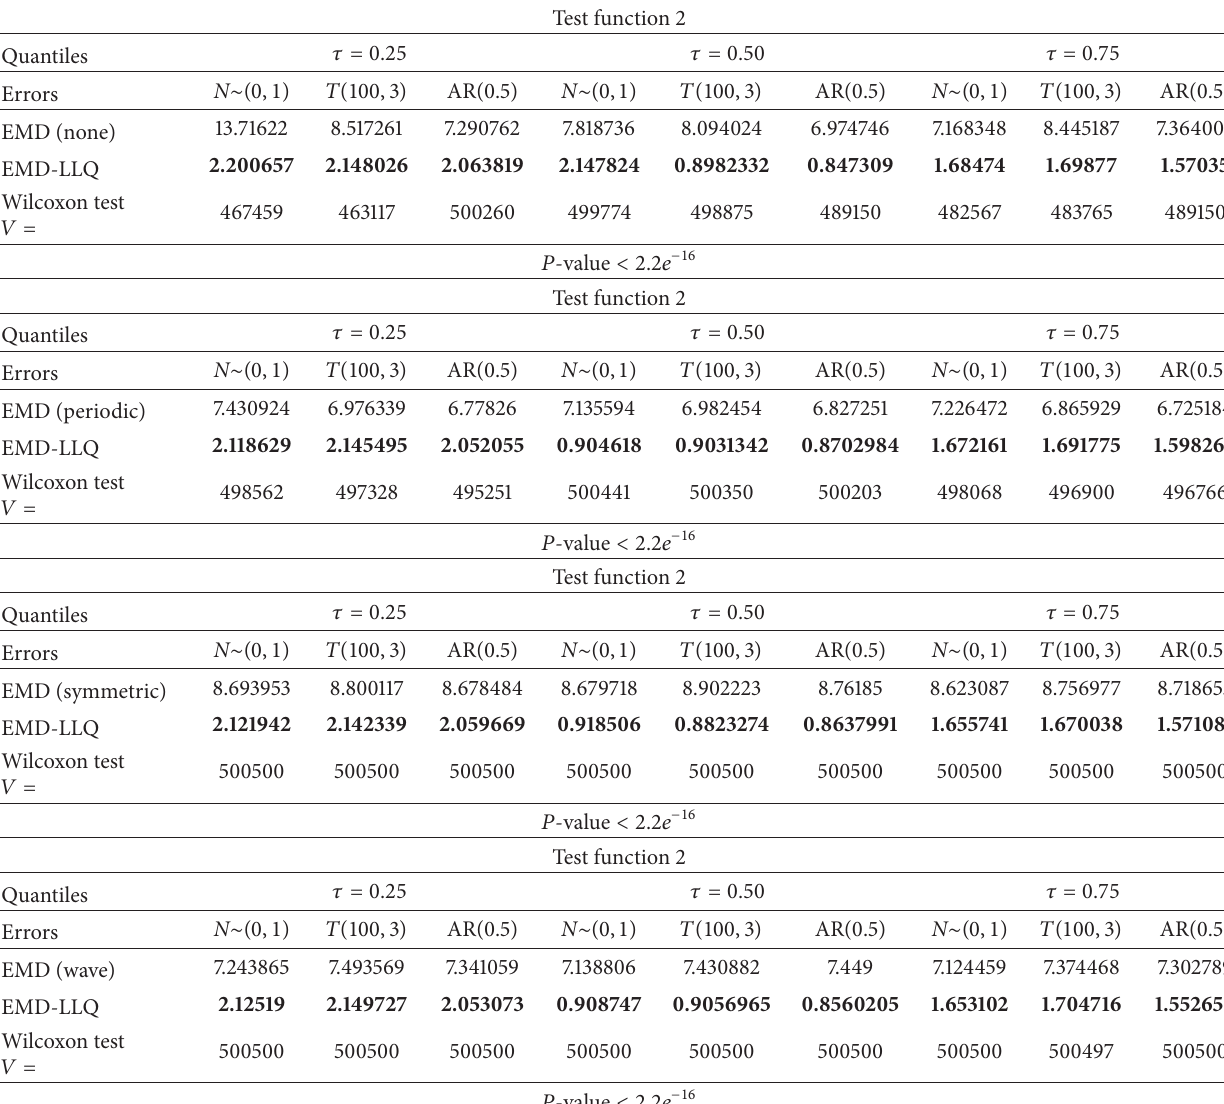
Table 3: The MSE of the classical EMD and proposed method under variety of boundary solution noise structure, different values of quantile 𝜏 (0.25, 0.50, and 0.75), and sample size =